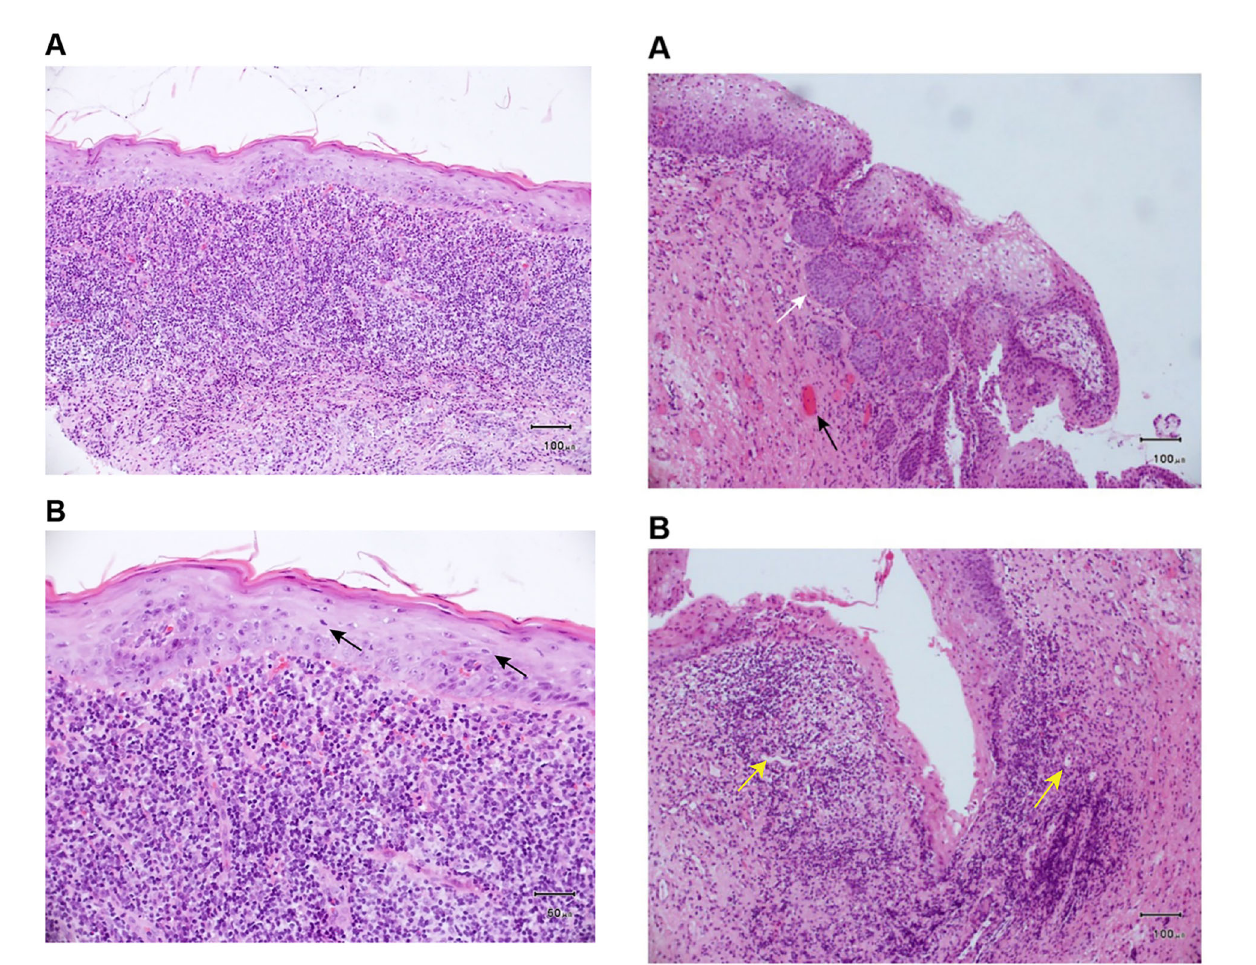
Figure 5. Vaginal wall biopsy. A , Squamous epithelial mucosa, with simple and pseudoepithelioma-like hyperplasia (white arrow) in some epithelium, hyperkeratosis and incomplete keratosis, and hyperplasia of interstitial small vessels (black arrow) Scale bar: 100 m m. B , Squamous epithelial mucosa, atrophy of part of the squamous epithelium, scattered super fi cial dermis, in fi ltration of focal lymph and plasma cells, and formation of lymphoid follicles (yellow arrows). Scale bar: 100 m